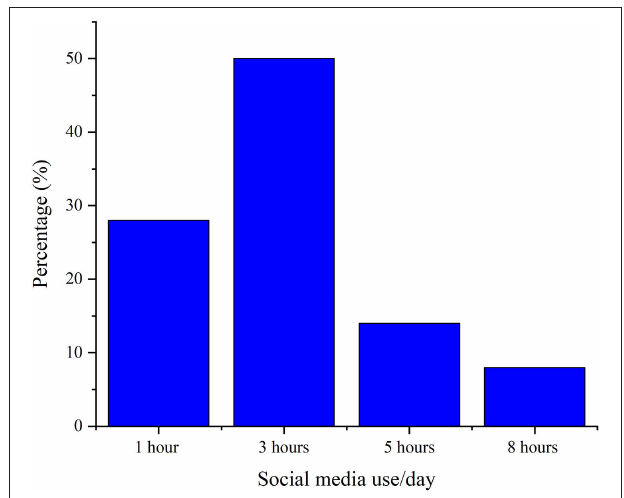
FIGURE 1 | Social media use per day among the study participants ( n = 726).